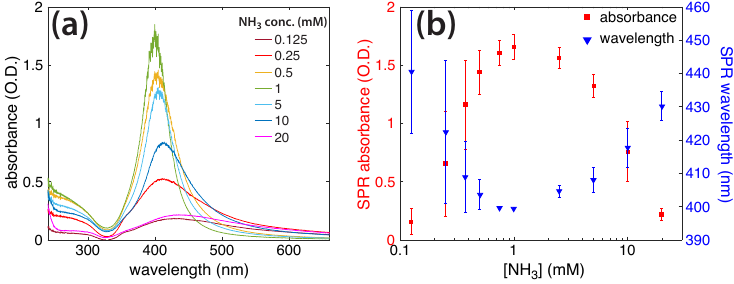
Figure 4. ( a ) Absorbance spectra of silver nanoparticles prepared with different amounts of NH labeled; ( b ) Surface plasmon resonance (SPR) absorbance (red, left) and SPR wavelength (blue, right) as function of NH 3